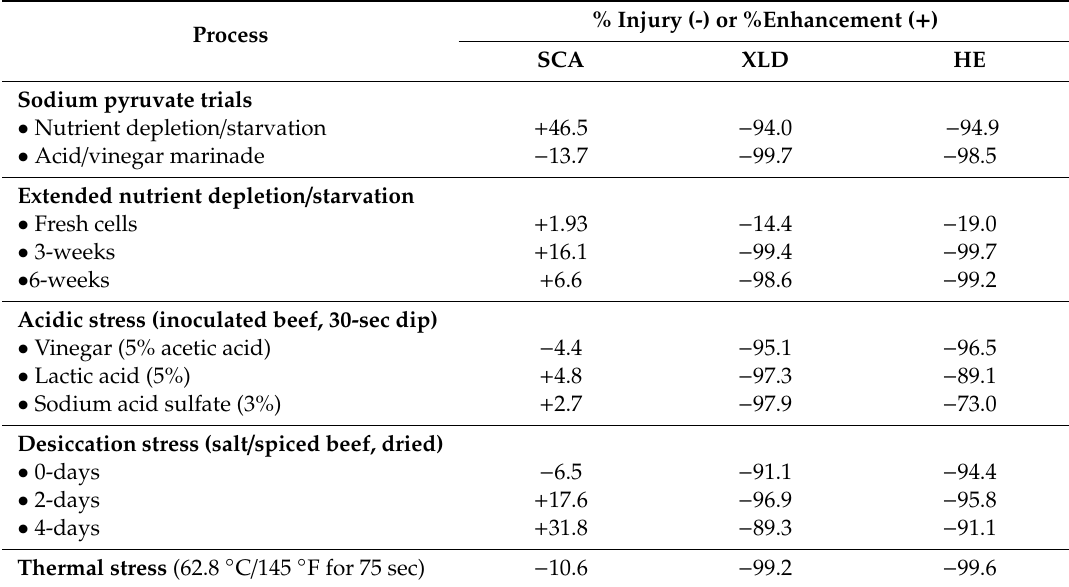
Table 2. Determination of % injury (-%) or enhancement ( + %) of Salmonella by comparison of microbial counts on selective media (SCA, XLD, HE) to non-selective meda (TSA).